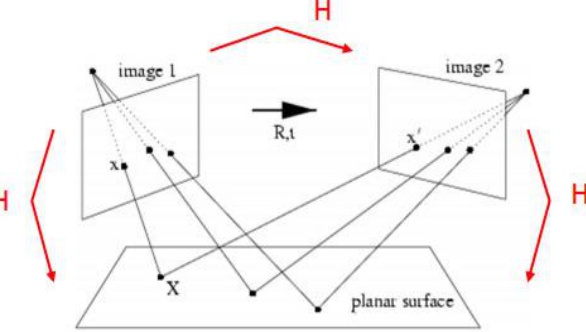
Figure 6. Definition of a homography matrix for projection (not real world).